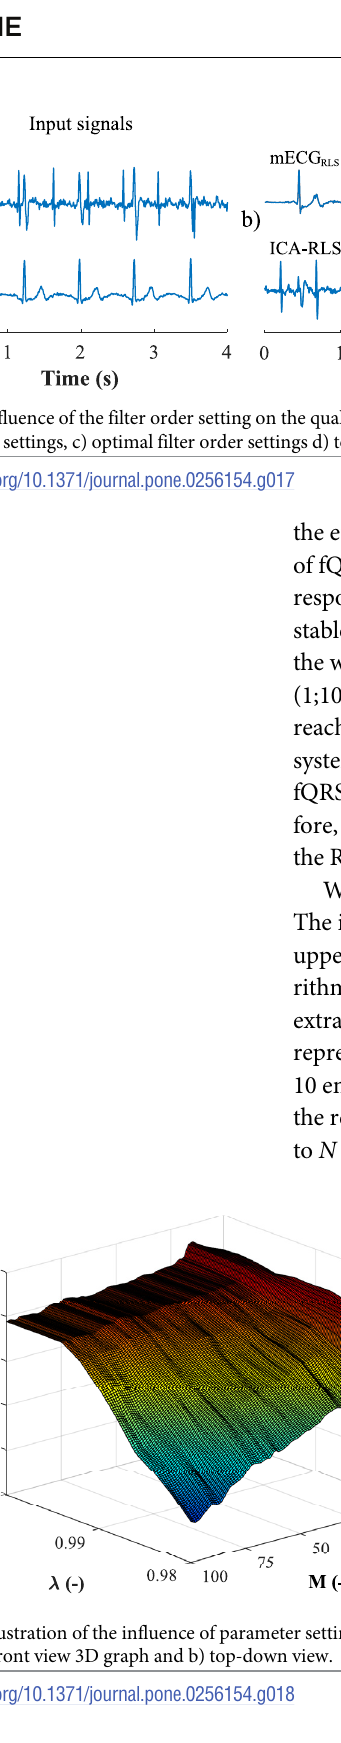
PLOS ONE | https://doi.org/10.1371/journal.pone.0256154 August 13,